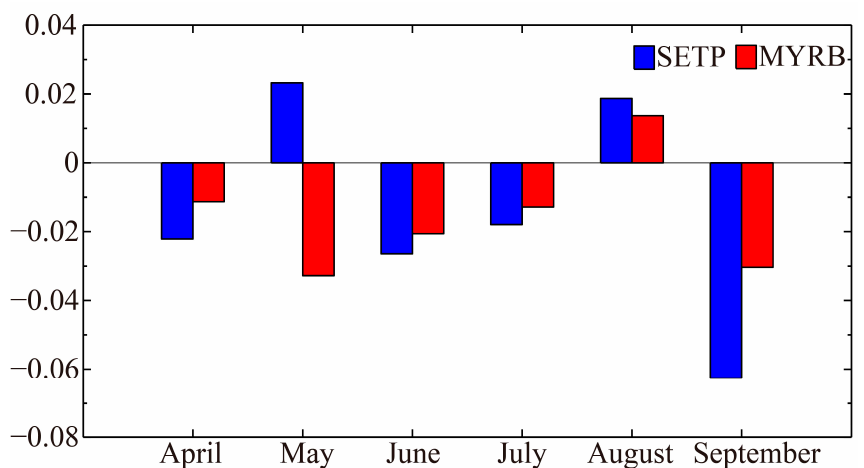
Figure 5. Linear trends of monthly mean precipitation (unit: mm d − 1 a − 1 ) for the SETP and the MYRB in the wet season over 1982–2011.